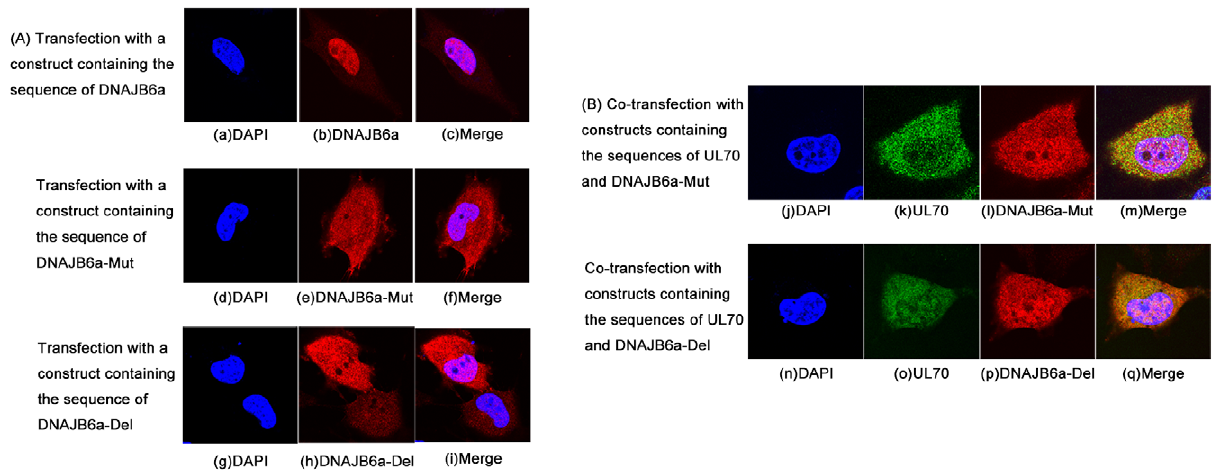
Figure 4. Role of the nuclear localization signal of DNAJB6 isoform a in the nuclear import of UL70. U251 cells were transfected with constructs pRK11-FLAG-DNAJB6a, pRK11-FLAG-DNAJB6a-Mut, and pRK11-FLAG-DNAJB6a-Del alone (A) and in the presence of construct plasmid pCMV-Myc-UL70 (B). At 48 hours posttransfection, cells were fixed, stained with antibodies, and visualized using a microscope. The images of Myc- tagged UL70 (k, o), FLAG-tagged DNAJB6a (b), DNAJB6a-Mut (e and l), and DNAJB6a-Del (h and p) and the nuclei stained with DAPI (a, d, g, j, and n) were used to generate the composite images (c, f, i, m, and q).